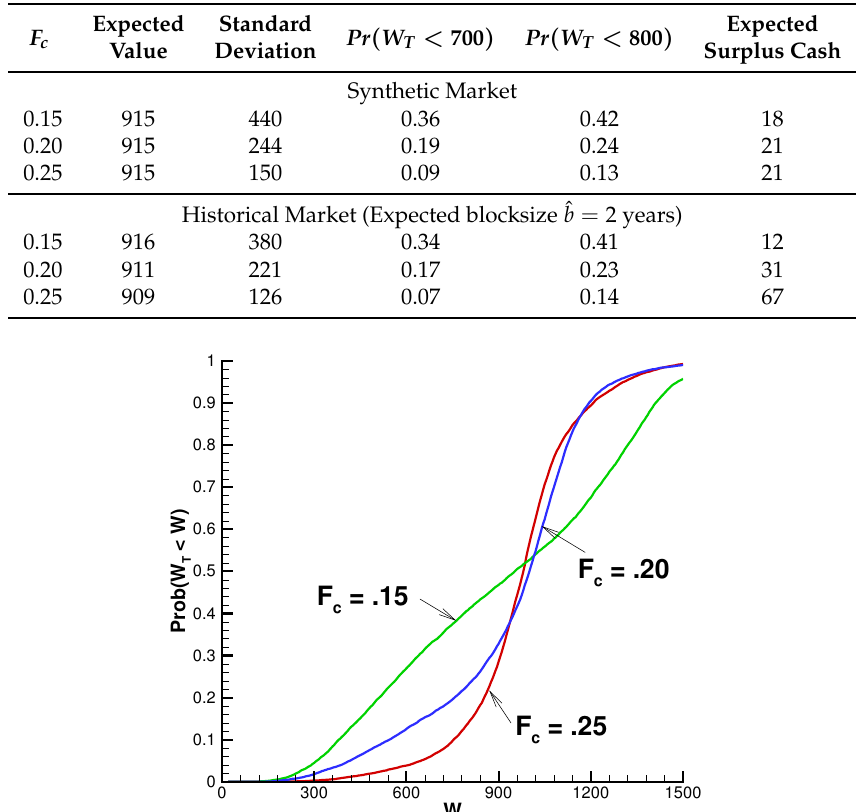
Table 5. Effect of varying contribution fraction F c for the QS optimal strategy. Wealth units: thousands of dollars. Input data provided in Tables 1 and 2, except as noted. Synthetic market results computed using Monte Carlo simulations with 160,000 sample paths. Historical market results based on 10,000 bootstrap resampled paths using data from 1926:1 to 2015:12.